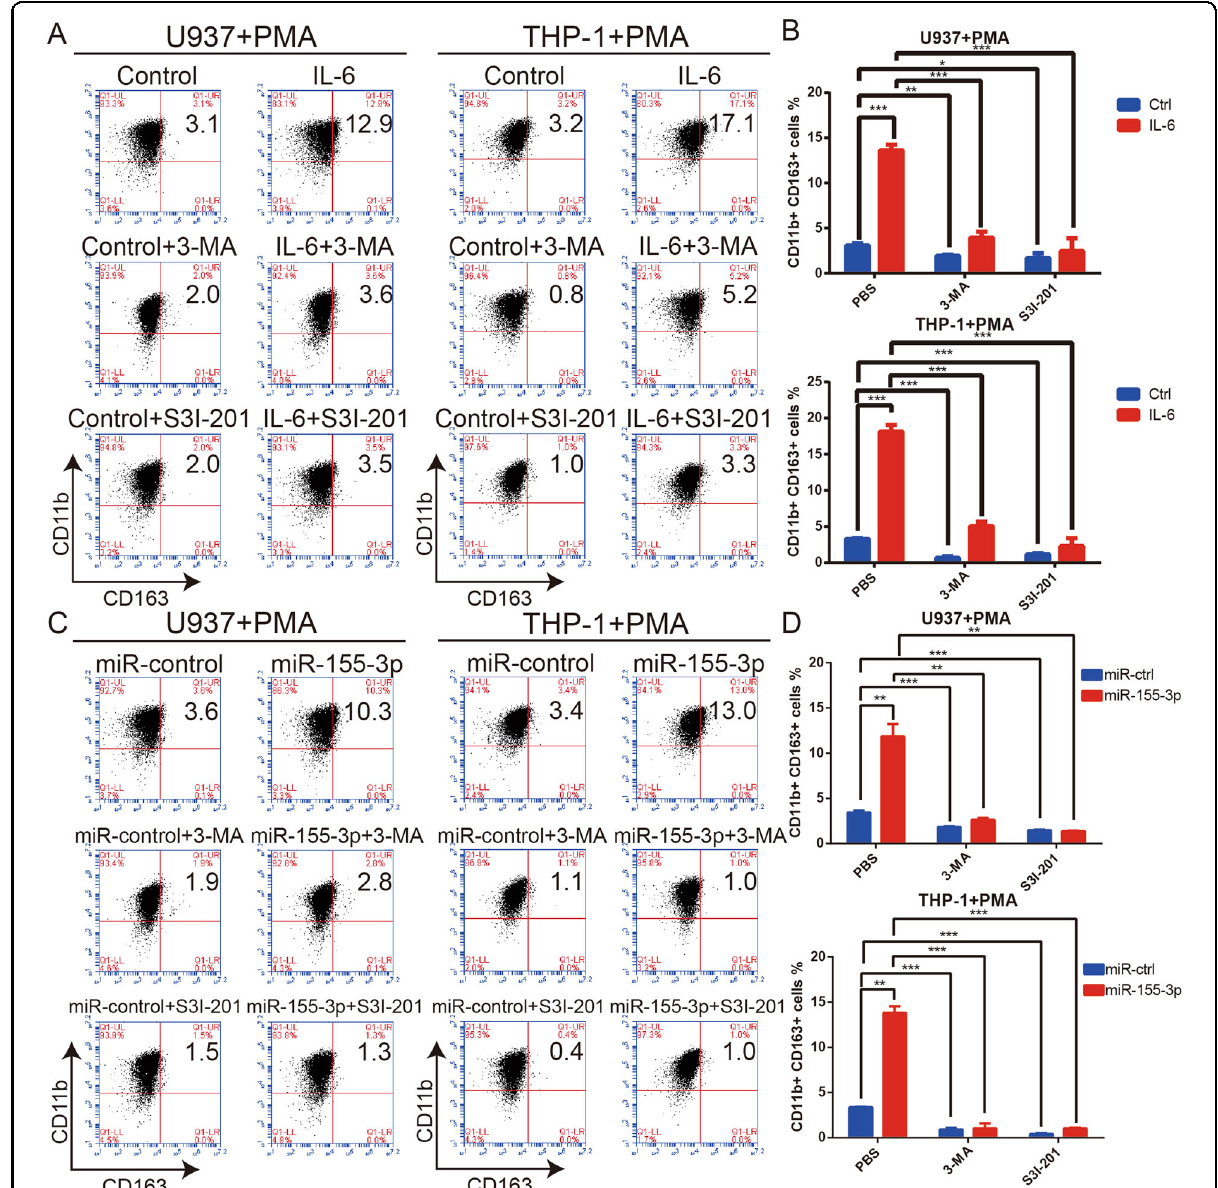
macrophages. 3-MA was used to inhibit autophagy. S3I-201 was used to inhibit STAT3 activation. Flow cytometry and quanti fi cation were performed to analyze the proportion of CD11b + CD163 + macrophages. C , D Human monocyte cell lines U937 and THP-1 were transfected with miR-control or miR-155-3p and incubated with PMA (100 ng/ml) for 24 h in vitro to induce them to differentiate into macrophages. 3-MA was used to inhibit autophagy. S3I-201 was used to inhibit STAT3 activation. Flow cytometry and quanti fi cation were performed to analyze the proportion of CD11b + CD163 + macrophages. (* P < 0.05; ** P < 0.01; *** P < 0.001; n =